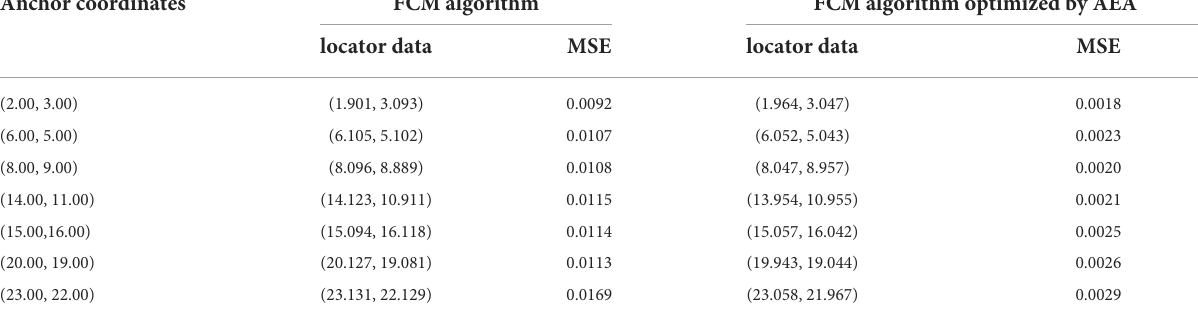
TABLE 3 Mean square error under the two